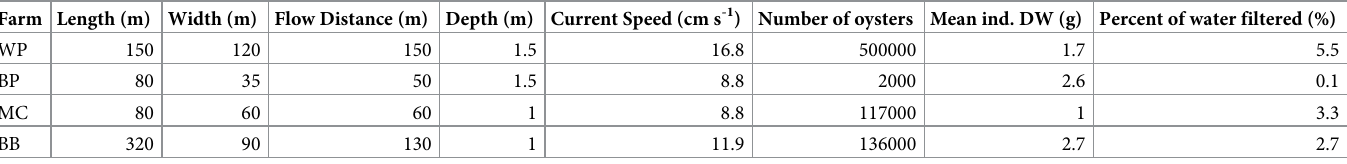
Table 4. Conceptual filtration volume calculations for each farm.